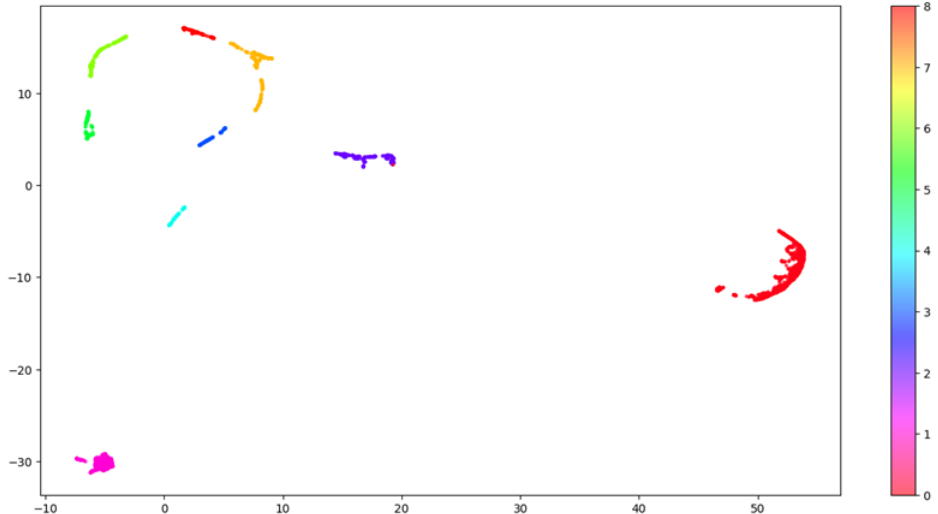
Figure 4. HDBSCAN clustering. This image shows the distribution of the clusters in the embedding space. The original embedding space including 64 dimensions was compressed into 2 dimensions using the UMAP algorithm to allow 2-dimensional visualization. Each one of the nine clusters is labelled using a distinct color.